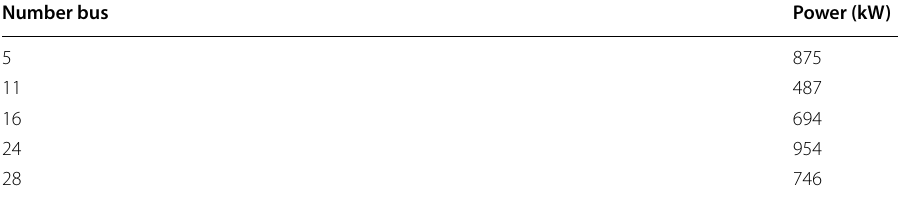
Table 1 Parameters of placement and sizing under the output power factor of the unit Number